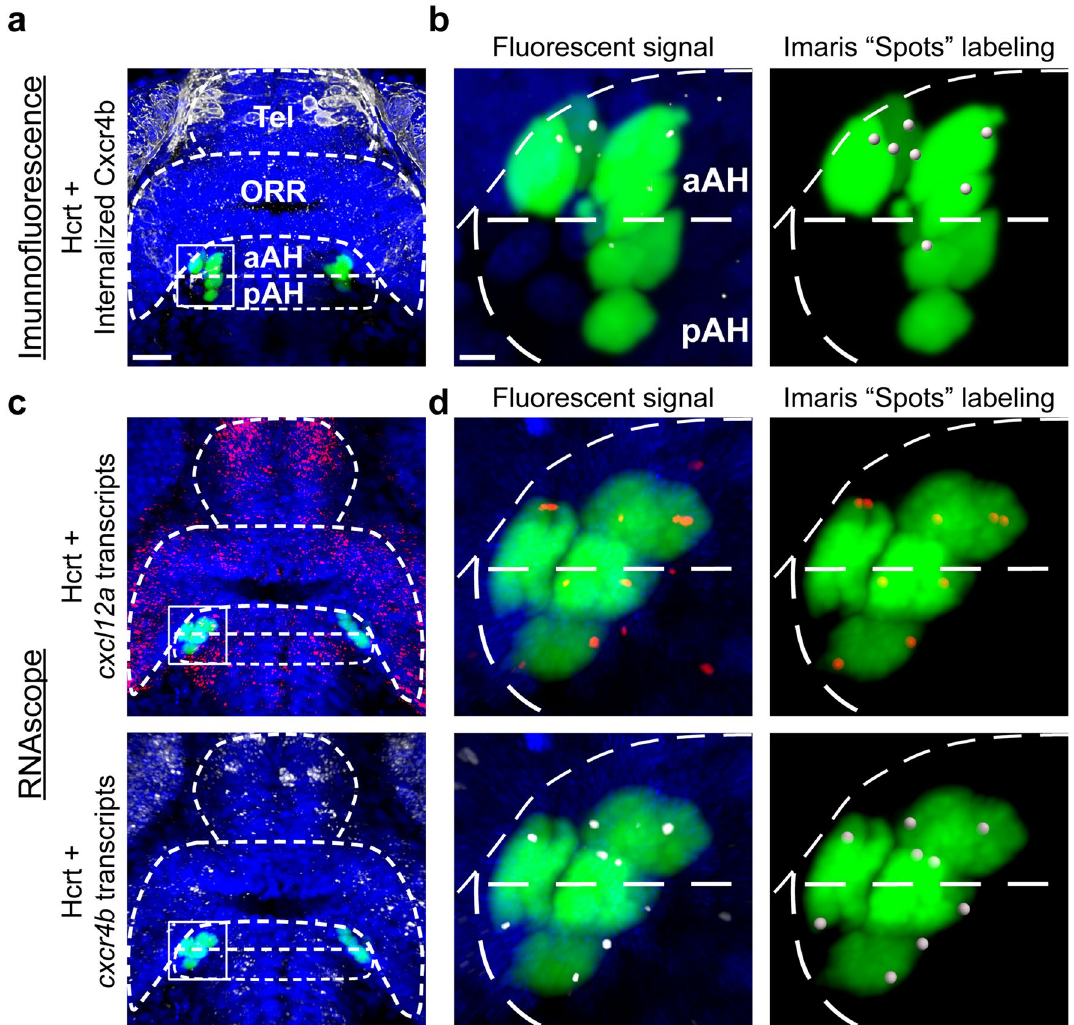
Figure 1. Photomicrographs illustrating the methodology used to quantify internalized Cxcr4b receptors colocalized within Hcrt neurons using immunofluorescence and also cxcl12a and cxcr4b transcripts colocalized within Hcrt neurons using RNAscope. ( A ) A representative confocal photomicrograph (×25) illustrates the 28 hpf zebrafish brain in a dorsal/ventral view with the aAH, pAH, ORR and Tel outlined by dashed lines. The Hcrt neurons (green) and internalized Cxcr4b receptors (white) are labeled using immunofluorescence, with counterstaining using DAPI (blue). ( B ) Enlargement of boxes at 28 hpf show the fluorescent signal (left) of the Hcrt neurons and internalized Cxcr4b receptors and the “Spots” labeling (right) of these internalized Cxcr4b receptors within Hcrt neurons using Imaris software for quantification. ( C ) Representative confocal photomicrographs (×25) show Hcrt neurons (green) with cxcl12a (top, red) and cxcr4b (bottom, white) transcripts labeled using RNAscope, with counterstaining using DAPI (blue). ( D ) Enlargement of boxes at 28 hpf show the fluorescent signal (left) of the Hcrt neurons and colocalized cxcl12a (top) and cxcr4b (bottom) transcripts and the Imaris “Spots” labeling (right) of these transcripts within Hcrt neurons using Imaris software for quantification. Scale bar low magnification 20 µm; high magnification 8 µm. aAH anterior part of the anterior hypothalamus, pAH posterior part of the anterior hypothalamus, ORR optic recess region, Tel telencephalon, Hcrt hypocretin, hpf hours post